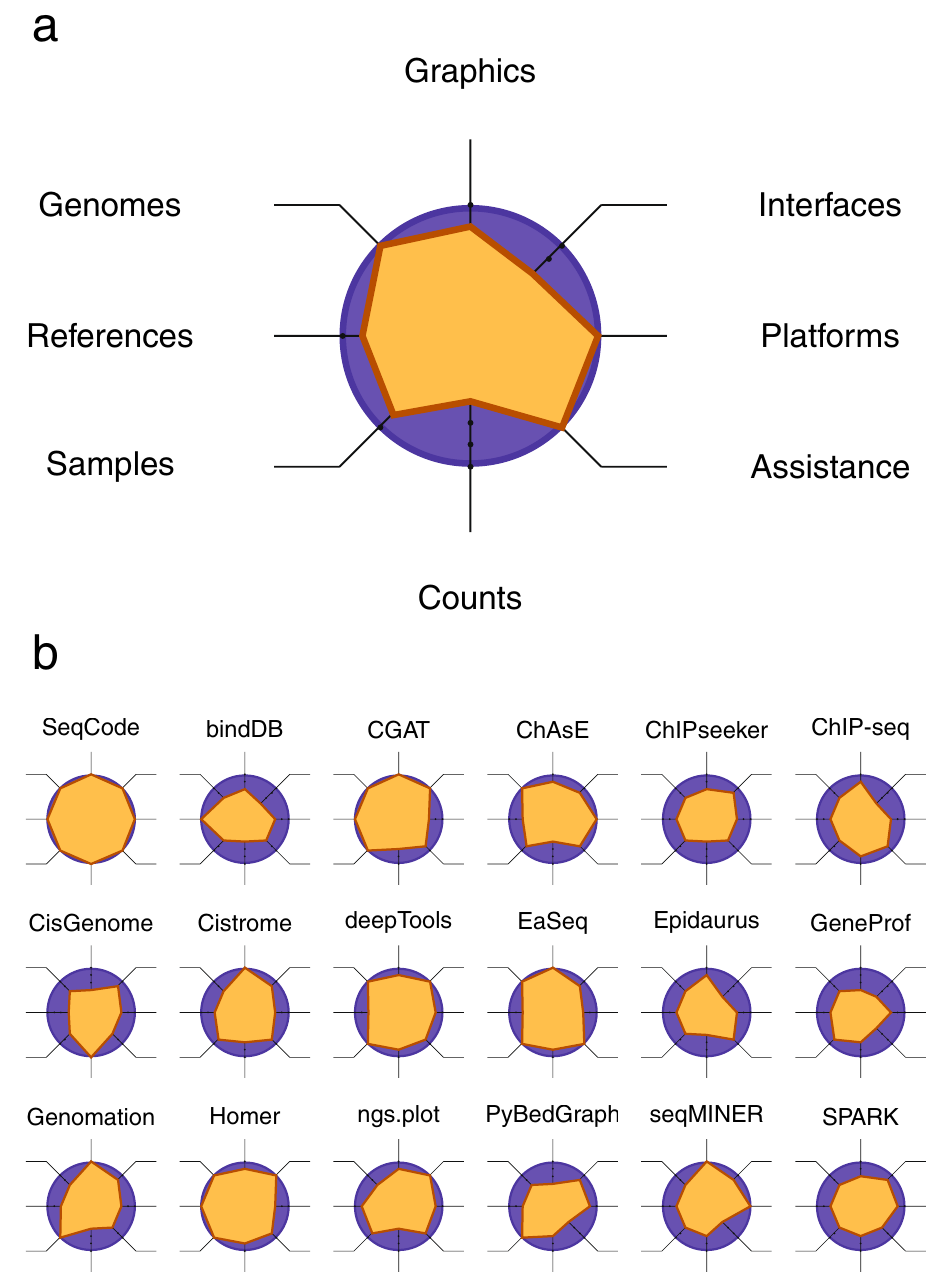
Figure 9. Evaluation of tools for the visualization of sequencing data. (a) Radar chart displaying the eight attributes that have been used to describe the characteristics of the existing applications. (b) Radar charts of each selected bioinformatics software for graphical summarizing sequencing data (see Table 3 for the values that are graphically displayed for each program